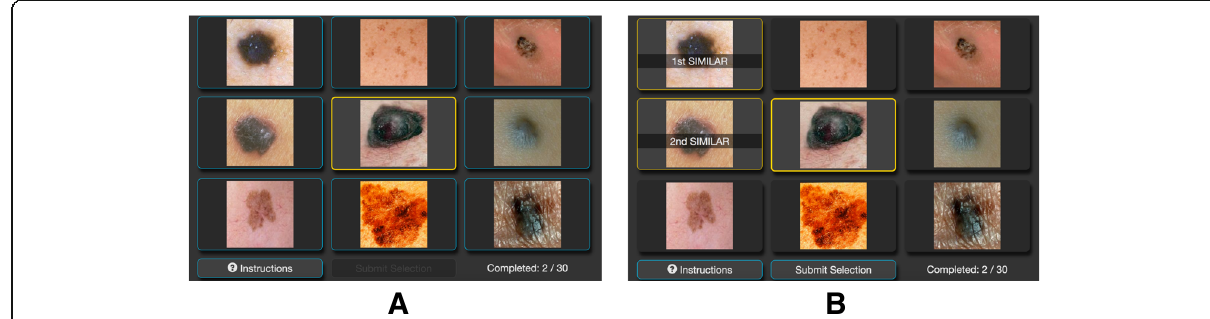
Fig. 1 Example similarity judgment displays shown to individuals. The center image is the query image while the surrounding images are the reference images. Participants select the two reference images that are most similar to the query. a Initially only the query is highlighted. b After the participant makes their selection, the selected references are also